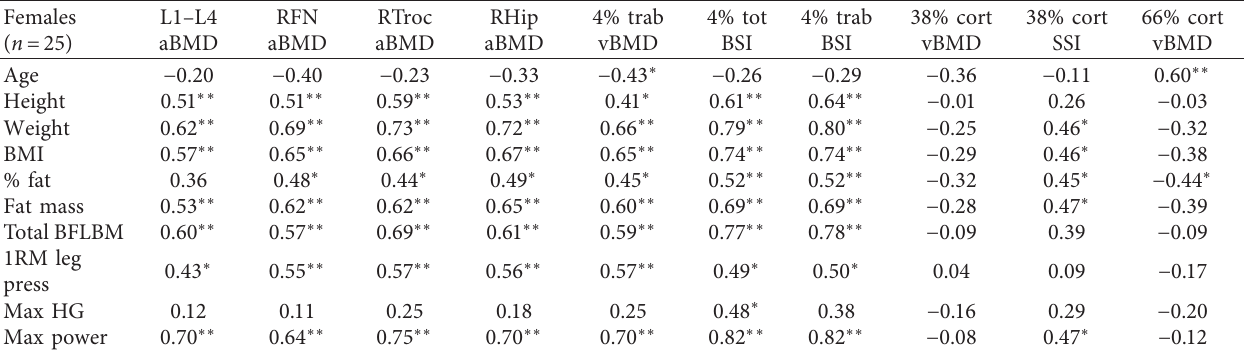
Table 7: Pearson correlation coefficients for age, height, body composition, muscle performance, and bone characteristics in females.